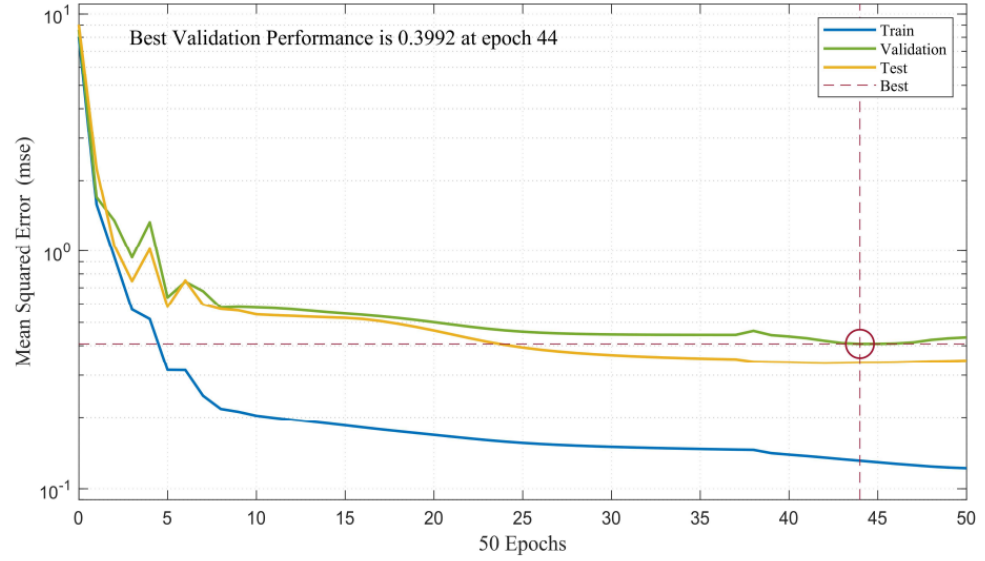
Figure 6. LM algorithm model performance.